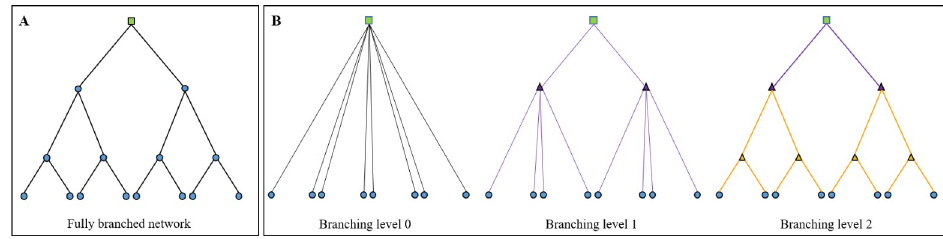
Fig 4. (a) A ‘fully branched’ network, with consumers at each junction, and (b) ‘evolved branching’ networks illustrating the addition of branch points and links over the course of the simulations. In each network, the green square is the resource, and the blue circles are consumers. In the ‘evolved branching’ networks, the branch points, represented by triangles, and links of the same colour denote when they were added during the evolution of branching: black links are the original network with no branch points, purple links and branch points are the first level of branching, and gold links and branch points are the second level, which also includes some branch points from previous levels. The network shown here is simplified for illustration purposes: the simulated ‘evolved branching’ networks contained seven levels of branch points at the final stage of development, and 512 consumers.